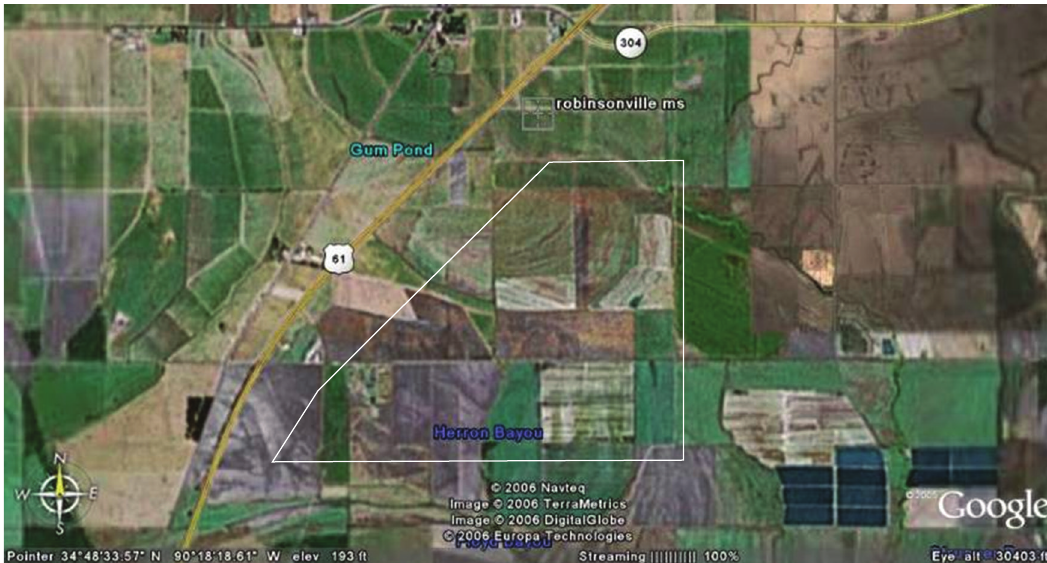
Figure 13: Location of Industrial Site (outlined in white) in Tunica County. (Adapted from Google Earth.)